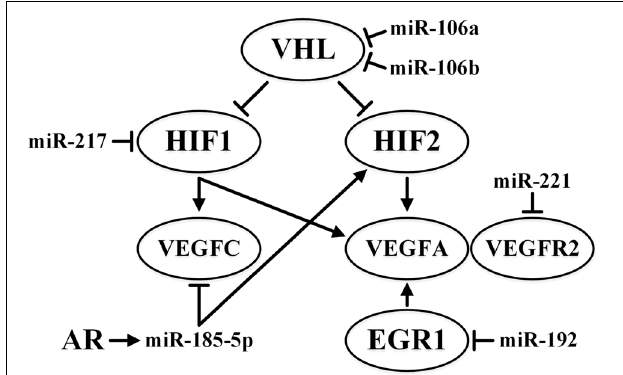
FIGURE 3 | Summary of the effects of miR-106a, miR-106b, miR-185-5p, miR-192, miR-217, and miR-221 on VHL/HIF pathways in ccRCC. ↑ indicates activity stimulation and (cid:62) indicates activity suppression according to any of the